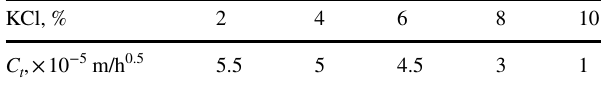
Fig. 5 Gas–liquid displacement in countercurrent imbibition